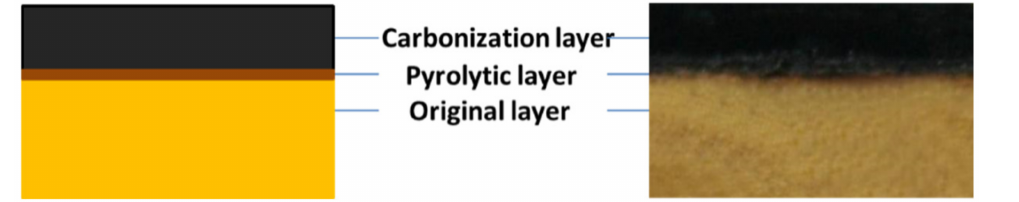
Figure 12. The different layers in the cross section of the ablative specimen.